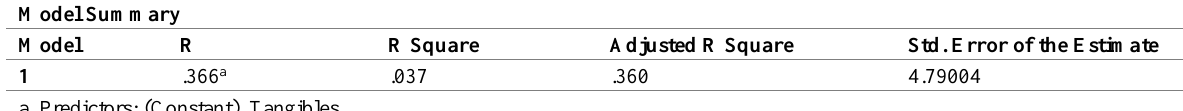
Table 16: Regression Analysis Relationship between Tangibles and Customer